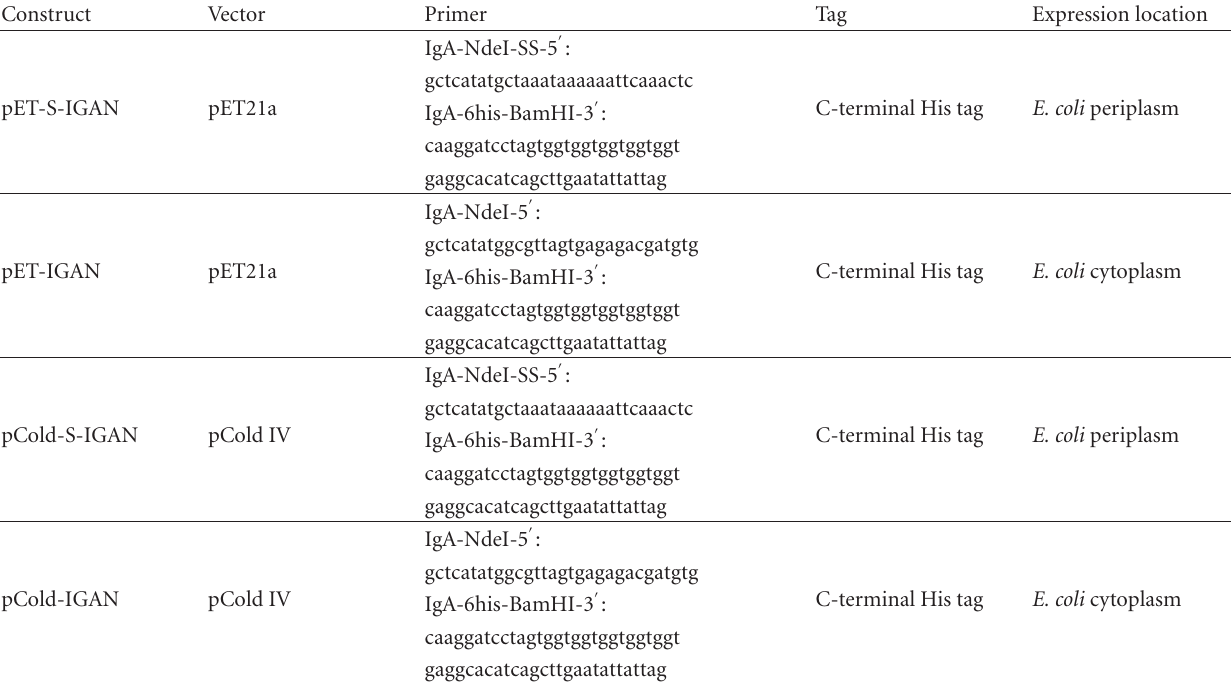
Table 1: IgA1 protease expression